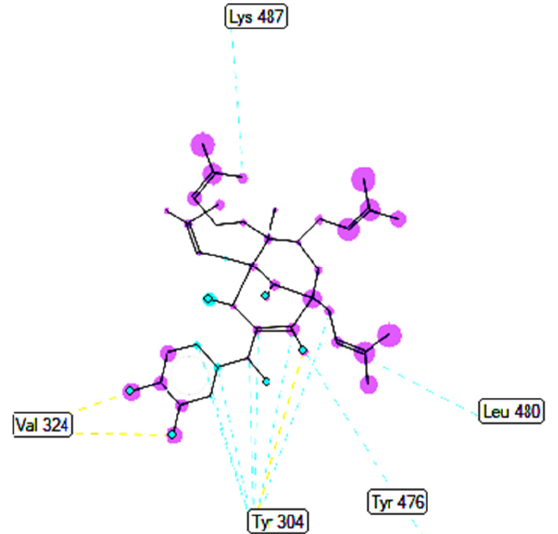
Figure 20. One 2D diagram exposing the significant ligand interactions between pose 35/200 and ligand 2VF5.